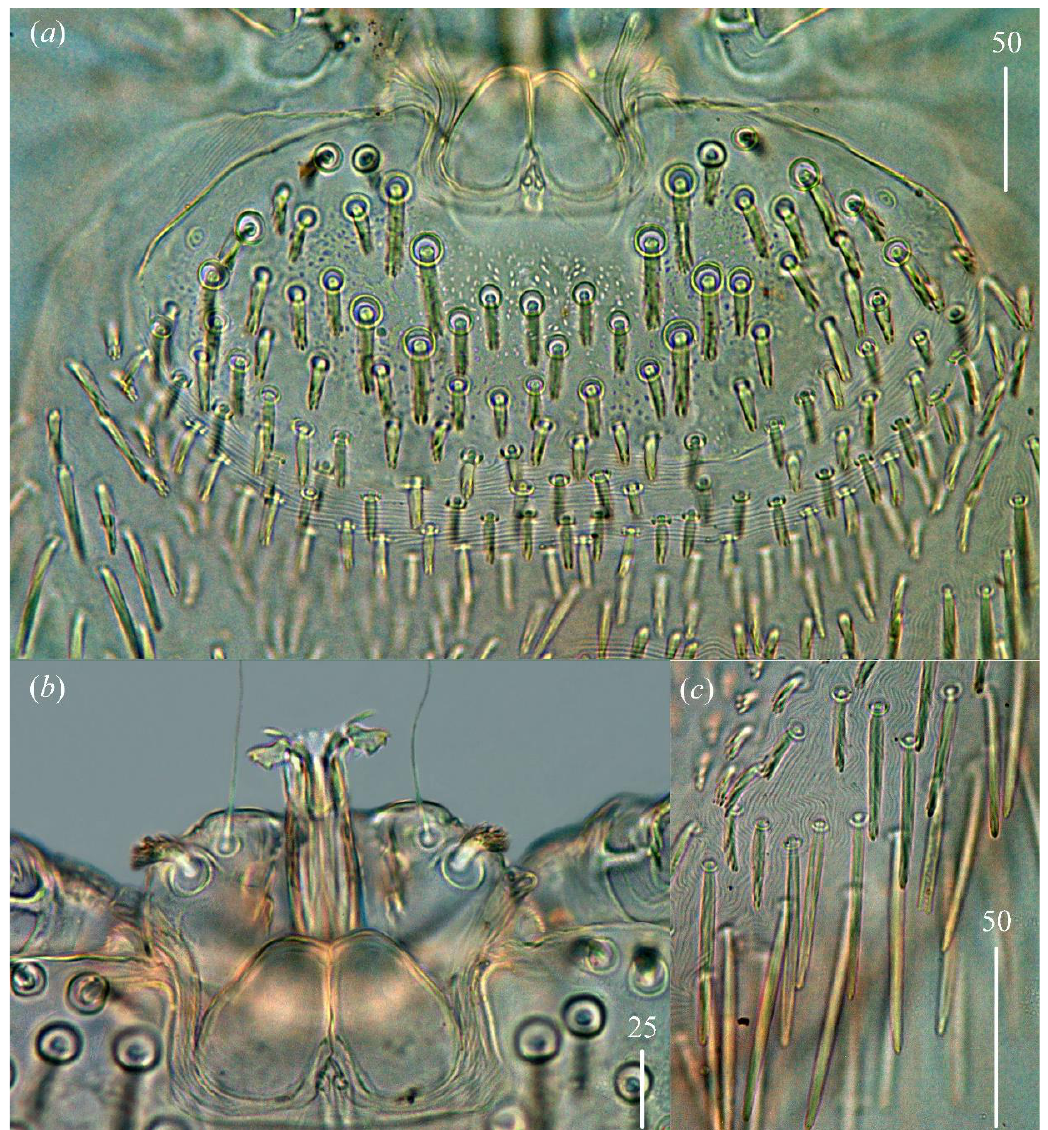
Figure 2. Geckobia gigantea sp. n., female, details: ( a ) propodonotal shield; ( b ), gnathosoma in dorsal view; ( c ) posterior dorsal setae.